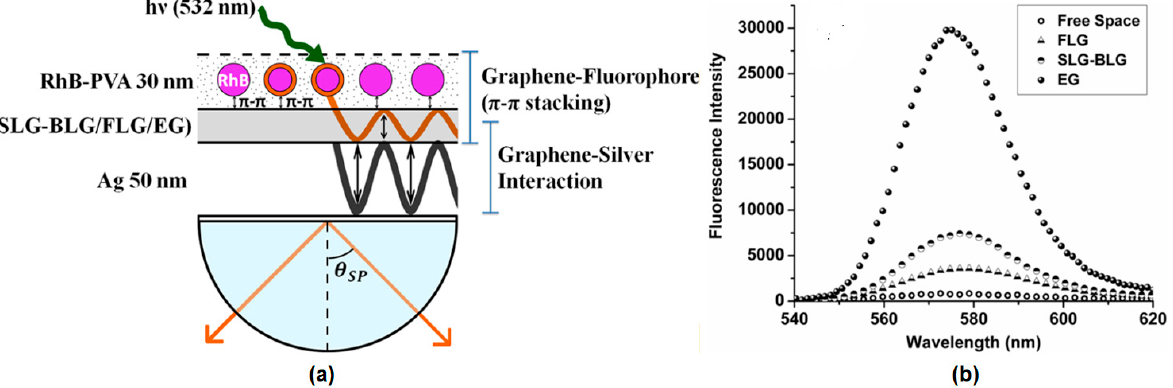
Figure 24. ( a ) Schematic depicting the graphene–fluorophore ( π – π stacking) and graphene–silver (plasmon–plasmon coupling) interactions. ( b ) Enhancement plot displaying intensity of the SPCE of the different Ag–graphene (Single layer graphene (SLG), bilayer graphene (BLG), few layered graphene (FLG), and exfoliated graphene (EG)) versus the intensity of the free space emission (adapted with permission from Reference [94], copyright American Chemical Society).